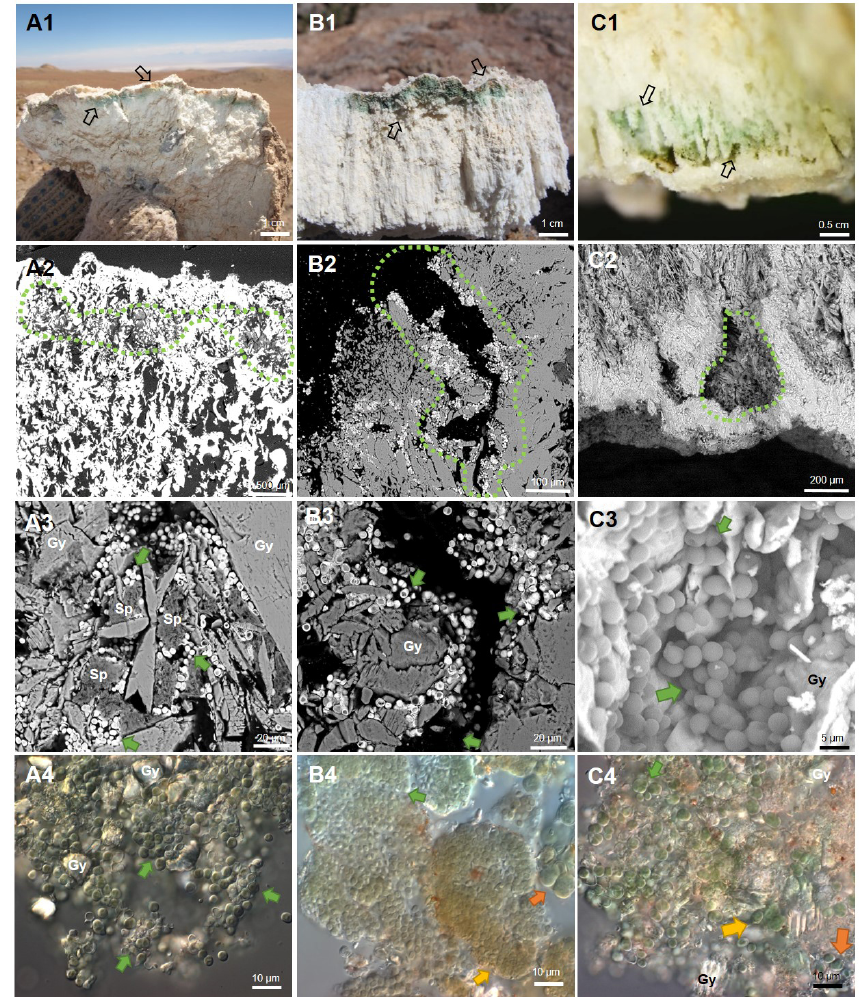
Figure 3. Characterization of endolithic colonization zones. Series A: cryptoendolithic; series B: chasmoendolithic; series C: hypoendolithic. Series 1: macro images of gypcrete cross sections of colonized zones; series 2 and 3: SEM-BSE images of gypcrete cross sections of colonized zones; series 4: LM-DIC images of scrapped Cyanobacteria from gypcrete. Series 1: black arrows indicate green and orange coloured endolithic colonization zones of 5mm thickness in A1 (CR), 8mm thickness in B1 beneath the surface (CH) and 5–9mm thickness in C1 above bottom gypsum crust (HE). Series 2: CR, CH and HE microhabitats with aggregates of endolithic microbial communities surrounded by the dotted green lines, inside the pores of gypcrete; A2 is under a white dense surface crust; B2 is inside the cracks of gypcrete, and C2 is inside the microcaves of gypcrete at the bottom of the rock. Series 3: green arrows point to aggregates of Cyanobacteria among gypcrete (Gy) crystals (A3, B3), surrounded by sepiolite (Sp), nodules (A3) and on the gypcrete (Gy) walls (C3). Series 4: aggregates of different morphotypes of cyanobacteria, shown by green, yellow and orange arrows, and gypcrete crystals (Gy).